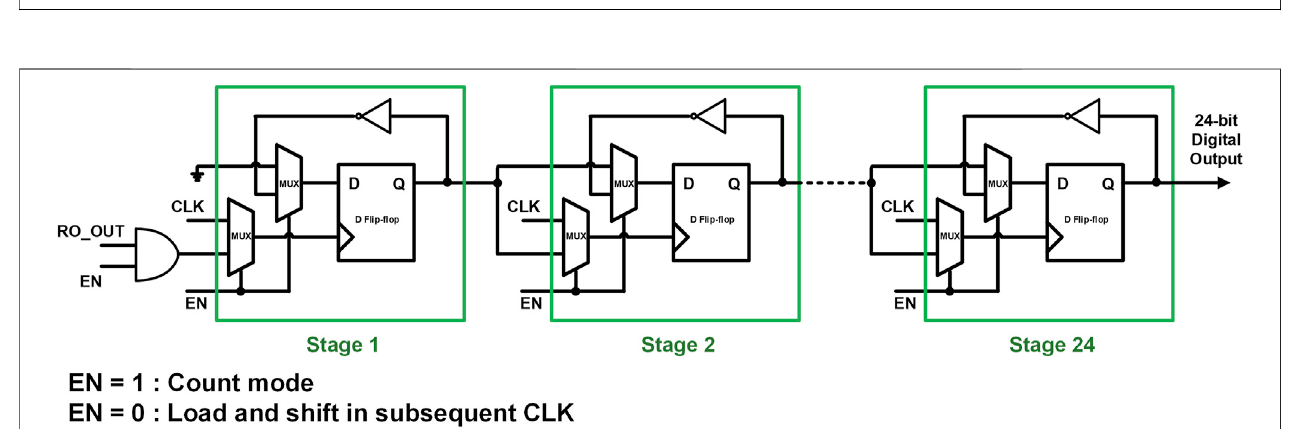
FIGURE 7 | Detailed circuit schematic of digital modules with count, load, and shift modes (frequency to digital conversion).